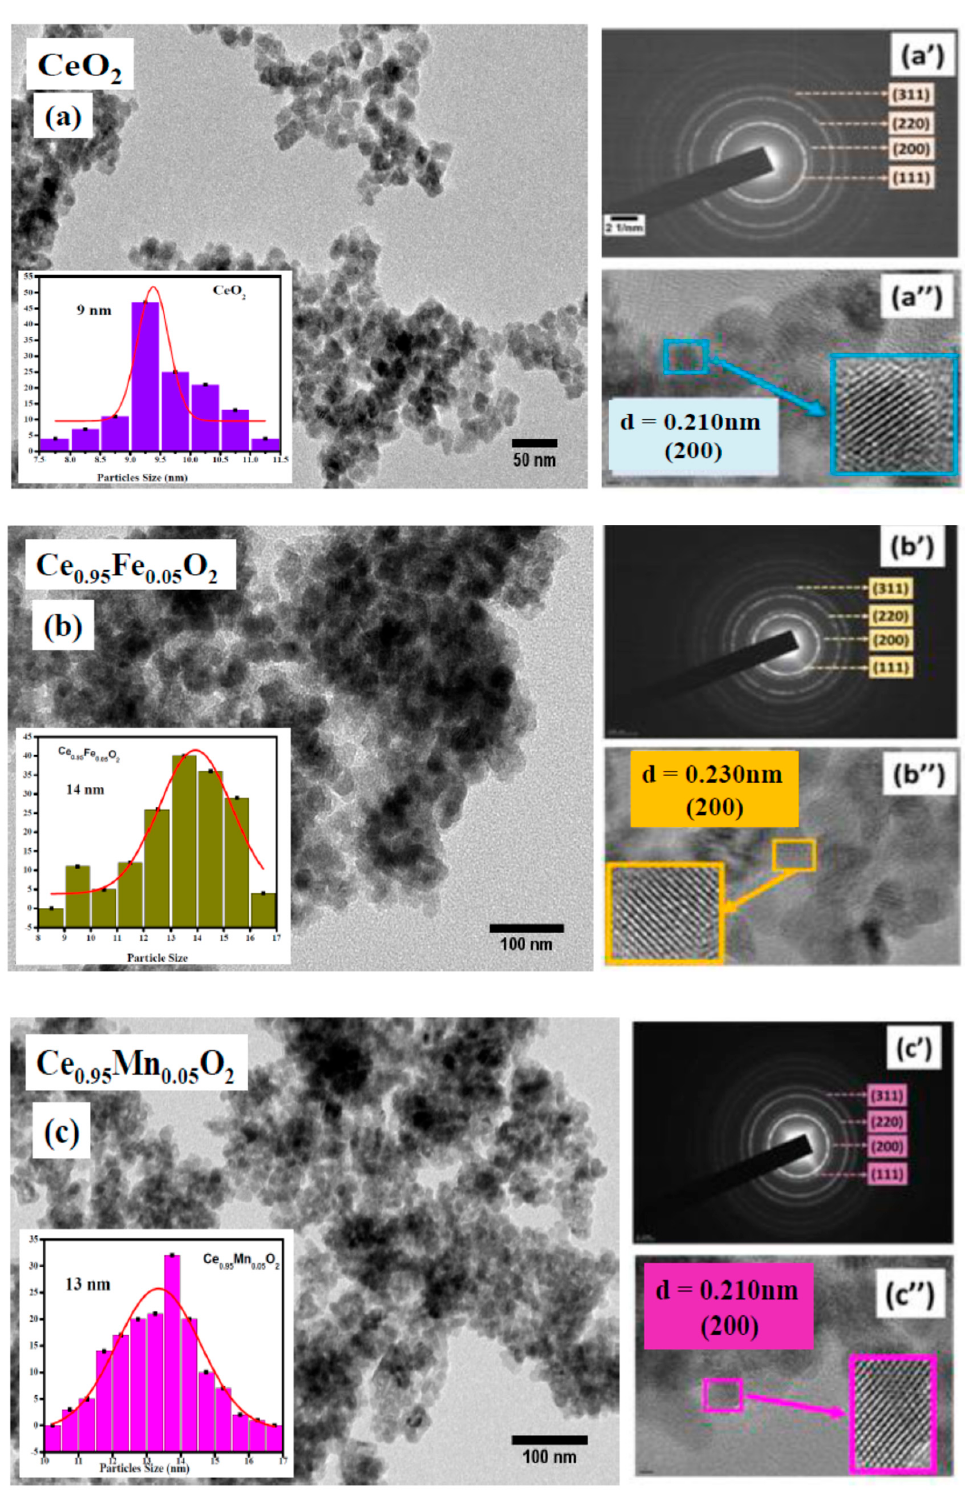
Figure 3. ( a , b , c ) Transmission Electron Micrographs of undoped and CeXO 2 (X: Fe, Mn) nanoparticles; inset shows the histograms representing particle size distribution fitted with Gauss function; ( a ′ , b ′ , c ′ ) shows the SAED patterns and ( a ″ , b ″ , c ″ ) highlights the HRTEM patterns of CeXO 2 (X: Fe, Mn) nanoparticles.